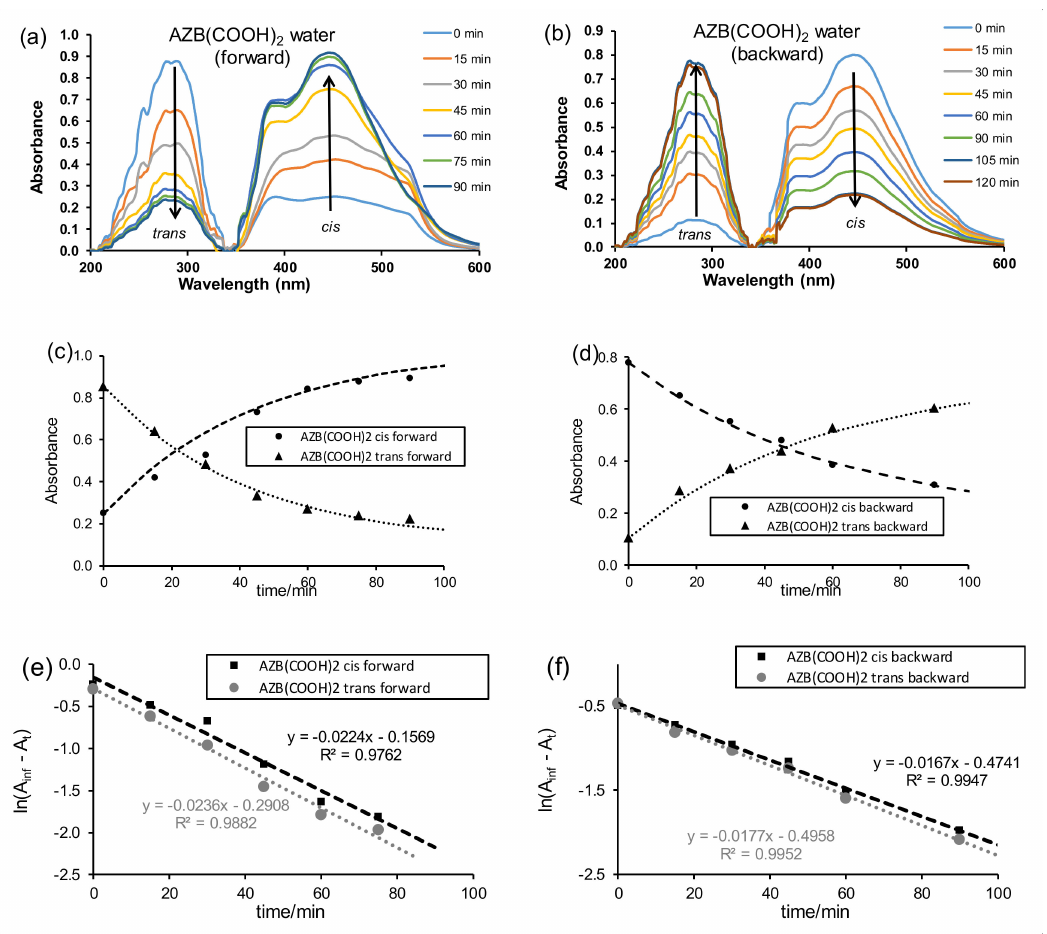
Figure 1. AZB(COOH) 2 (10 ppm in water) plots of trans – cis (forward) isomerisation ( a , c , d ) and cis–trans (backward) isomerisation ( b , d , f ). ( a , b ) UV–Vis absorbance vs. wavelength, ( c , d ) absorbance (A) vs. time, ( e , f ) ln(A inf - A t ) vs. time. The trans–cis isomerisation of the free AZB(COOH) 2 ligand in water (10 ppm or 4 × 10 − 5 M) under irradiation of UV light, as followed on UV–Vis (Figure 1a,c), reached equilibrium after ca 120 min. Photo-isomerisation was observed by the decrease of the UV–Vis absorption band at 294 nm ( trans ) and an increase of the absorption band at 445 nm ( cis ). The assignment of the trans and cis absorption peaks was in accordance with the literature [22] and confirmed by a TDDFT study presented in Section 5 below. The rate constants for the trans–cis (forward) isomerisation obtained from absorbance data at 294 nm (0.0236 min − 1 or 0.00039 s − 1 ) and that measured at 445 nm (0.0224 min − 1 or 0.00037 s − 1 ) were kinetically the same (Figure 1e). The rate constants for the cis–trans (backward) isomerisation (Figure 1b,d) obtained from absorbance data at 294 nm (0.0177 min − 1 or 0.00030 s − 1 ) and that measured at 445 nm (0.0167 min − 1 or 0.00028 s − 1 ) were kinetically the same (Figure 1f). The average rate constant for the cis–trans (backward) isomerisation (0.017(1) min − 1 or 0.00029(1) s − 1 ) was slightly slower than the average rate constant for the trans–cis (forward) isomerisation (0.023(1) min − 1 or 0.00038(1) s − 1 ) for 4 × 10 − 5 M solution of AZB(COOH) 2 . Similarly, it was found that, for AZB(COOH) 2 in (i) DMF, the cis–trans (backward) isomerisation (0.013(1) min − 1 or 0.00022(1) s − 1 ) was slightly slower than